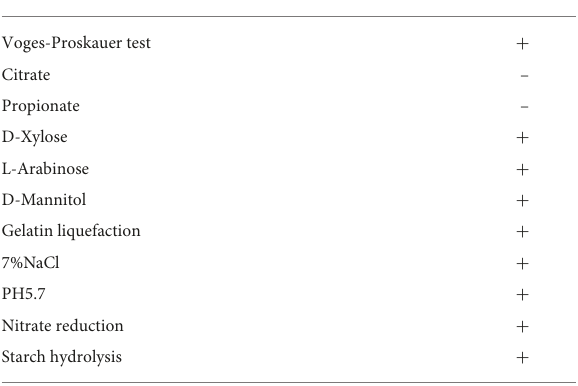
TABLE 1 Physiological and biochemical characteristics of SYL-3